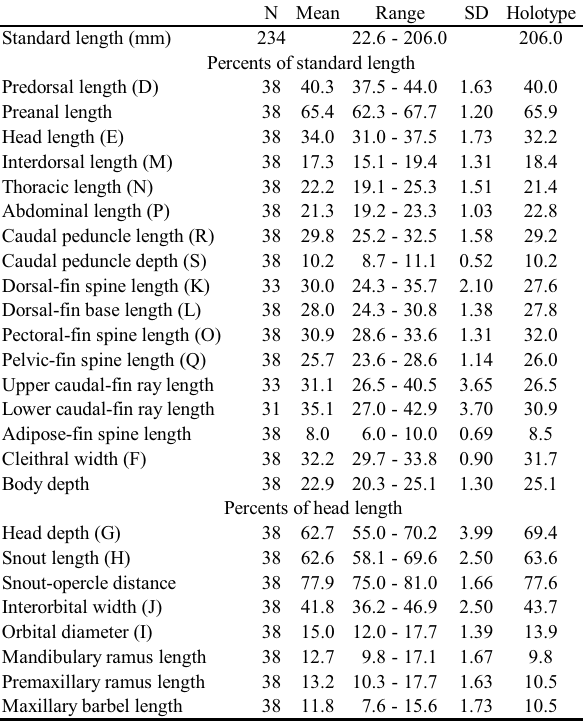
Table 1. Morphometric data of Hypostomus faveolus . Letters in parenthesis correspond to measurements in Boeseman (1968: fig. 5).